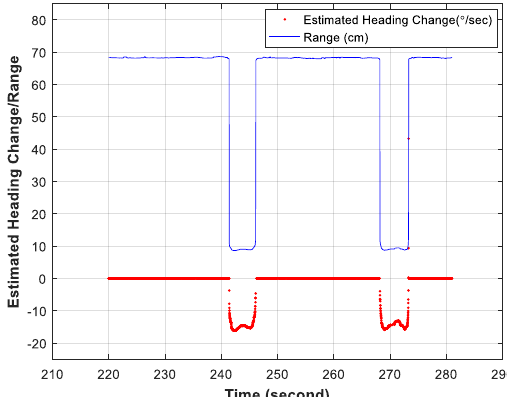
Figure 10. Regression Model Estimation Scheme between the ultrasonic range and the GNSS/INS change of heading during GNSS signal availability.